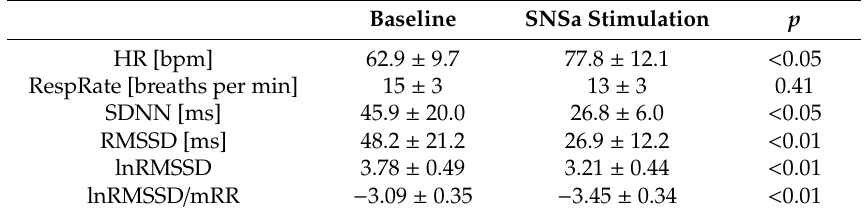
Table 1. The e ff ect of sympathetic nervous system activity (SNSa) stimulation on short-term 5 min heart rate (HR), respiratory rate (RespRate), and time-domain heart rate variability (HRV)